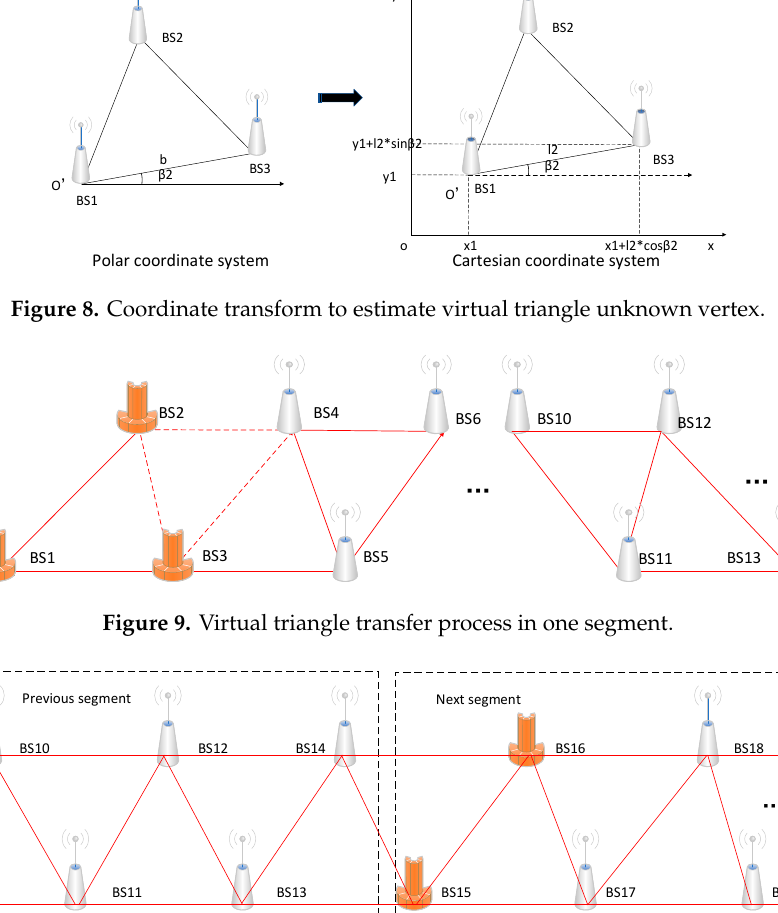
l3 a) Cartesian coordinate system Figure 6. Coordinate system transformation process.